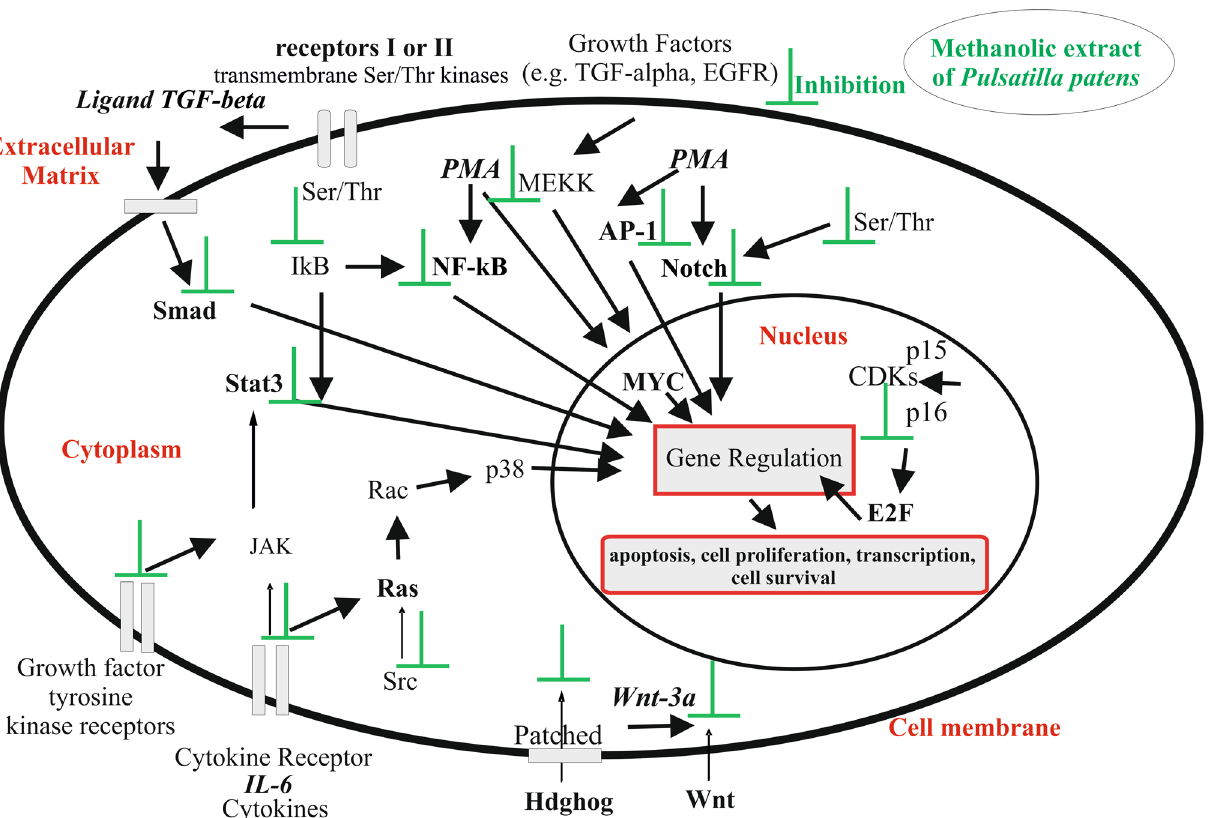
Figure 3. Cancer-related signaling pathways in HeLa cells inhibited by P. patens methanolic extract and the mechanism of extract P. patens action in the cancer cell. The methanolic extracts of P. patens enhance apoptotic death, deregulated cellular proliferation, differentiation, and progression towards the neoplastic phenotype by altering key signaling molecules required for cell cycle progression. Stat3, Smad, AP-1, NF-κB, E2F, MYC, Notch, Wnt, Hdghog, Ras Transcription factors, Cytokines IL-6, Ligand TGF-beta Inducers, PMA Protein kinase activator, phorbol 12-myristate-13-acetate, Wnt-3a protein, Ser/Thr Serine/threonine kinases, EGFR Epidermal growth factor receptor, MEKK Mitogen-activated protein (MAP) kinase, IkB Inhibitor of kB, JAK Janus kinase, Src Protooncogene tyrosine-protein kinase, Rac Subfamily of the Rho family of GTPases, Ras Ras family kinase,